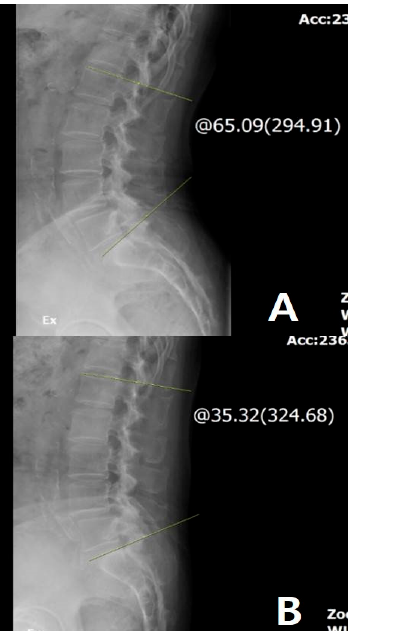
Table 1. Data of all sagittal parameters.